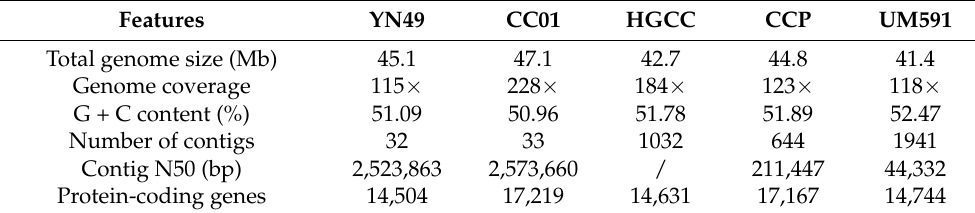
Table 1. Genome characteristics and assembly features of C. cassiicola isolates YN49, CC01, HGCC,